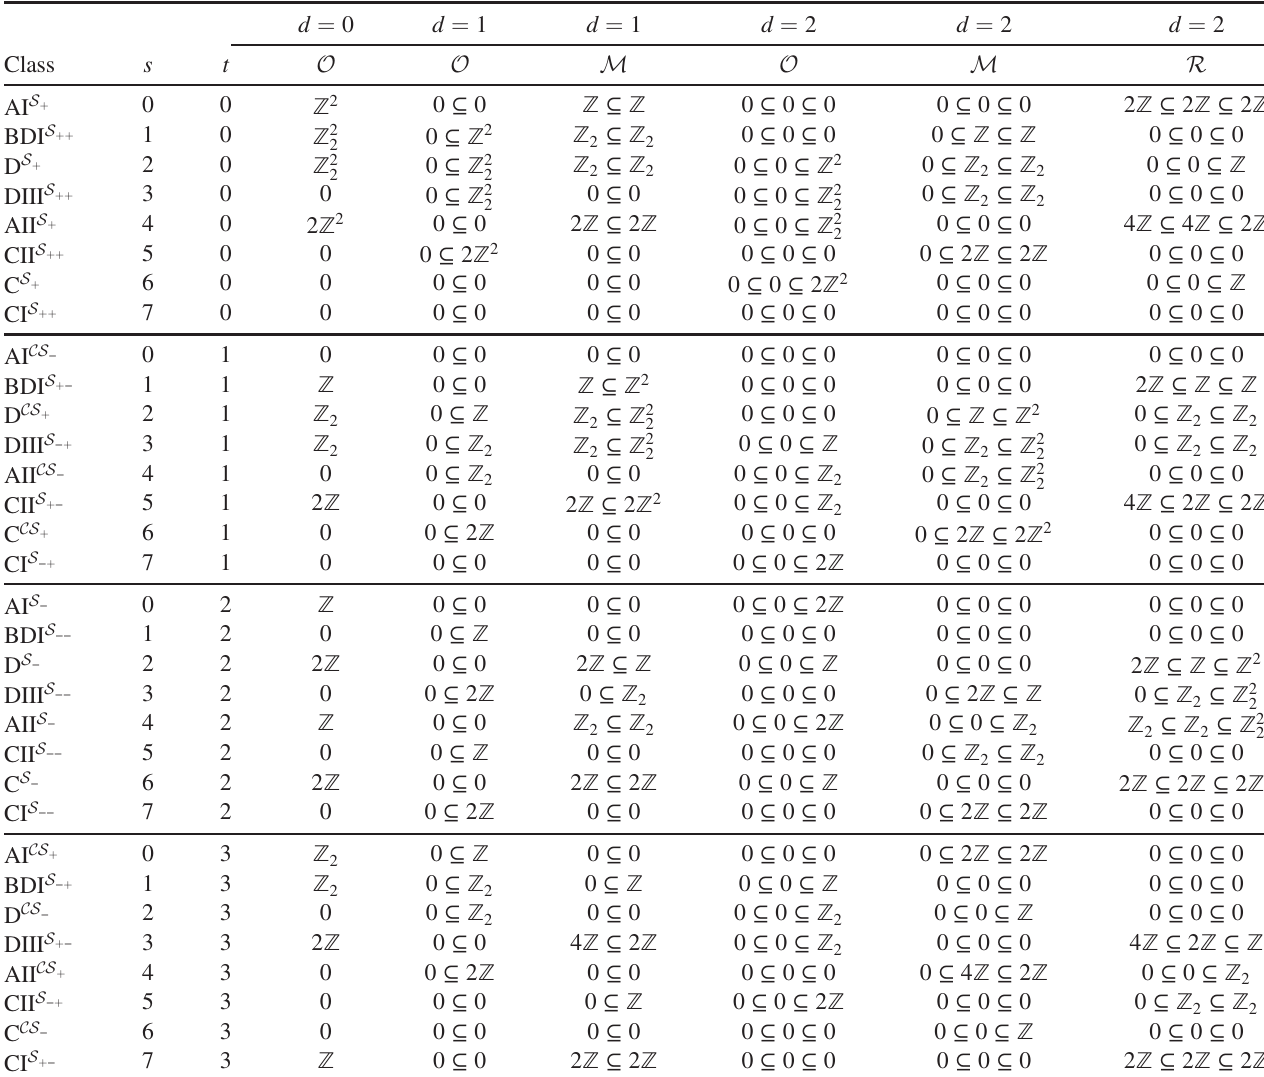
TABLE IV. Bulk classification sequence K ð d Þ ⊆ (cid:3) (cid:3) (cid:3) ⊆ K 0 ⊆ K for zero- ( d ¼ 0 ), one- ( d ¼ 1 ), and two-dimensional ( d ¼ 2 ) topological crystalline phases with an order-two crystalline symmetry or antisymmetry for the real tenfold-way classes. The symbols O , M , and R refer to a local on-site ( d ¼ 0 ), mirror ( d ¼ 1 ) and twofold rotation symmetry ( d ¼ 2 ), k k k